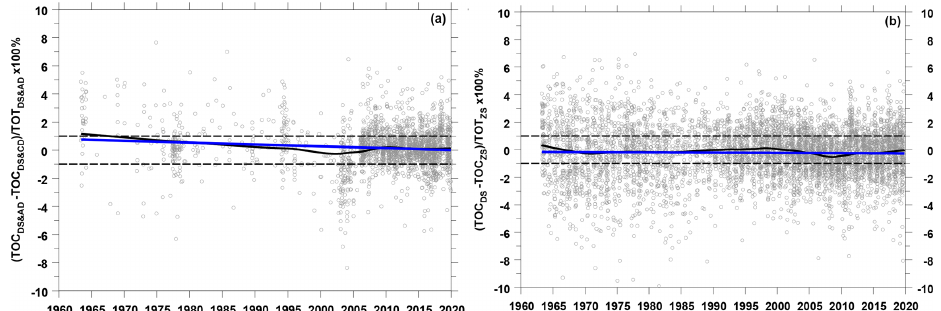
Figure 3. Time series of relative differences between daily means of TCO 3 : DS–AD vs. DS–CD measurements (a) and DS vs. ZS measure- ments (b) . The black curve shows the smoothed pattern of the data. The blue line is the linear regression line.